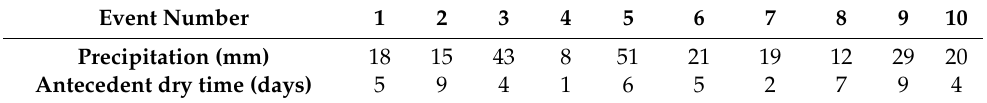
Table 5. Storm event number, precipitation volume, and antecedent dry time.